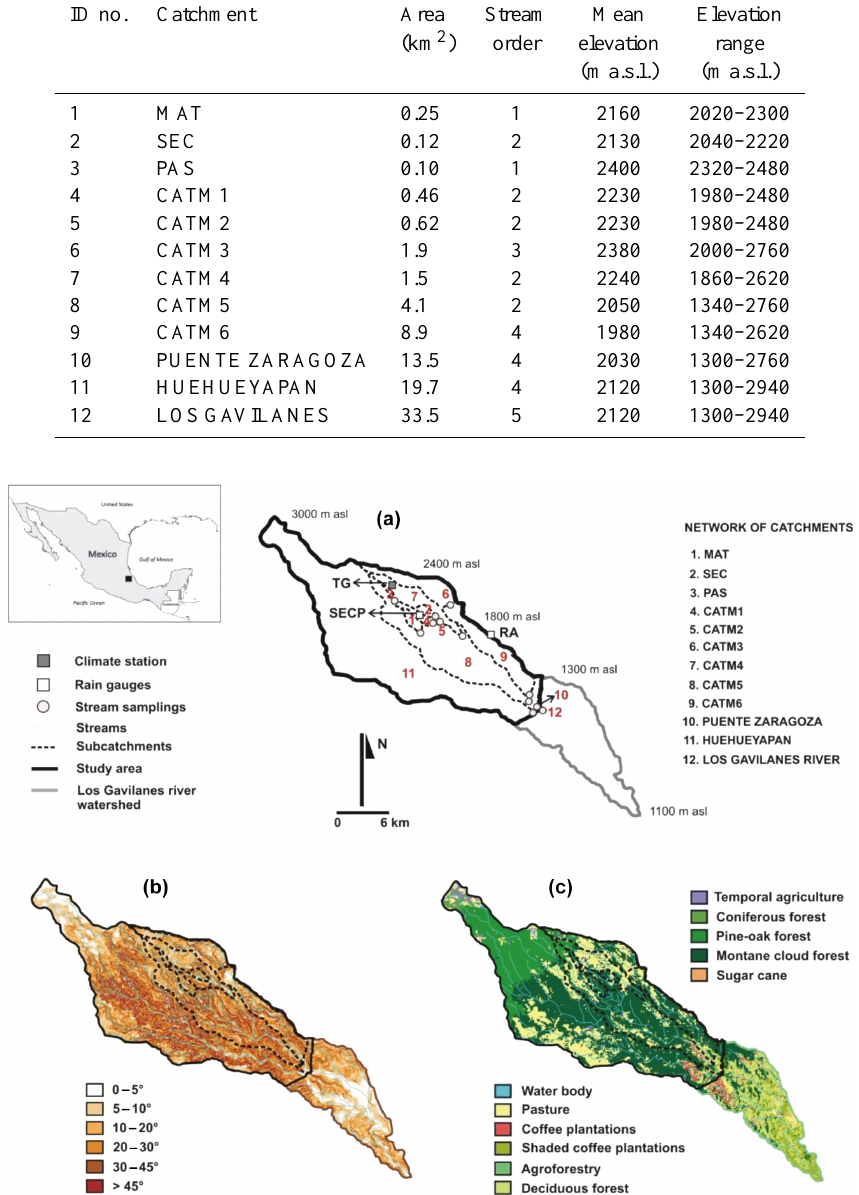
Figure 1. Location of the study site in central Veracruz, eastern Mexico, and maps of the Los Gavilanes catchment showing (a) the stream and rain water collection points, (b) slopes, and (c) land covers (see text for further explanation).